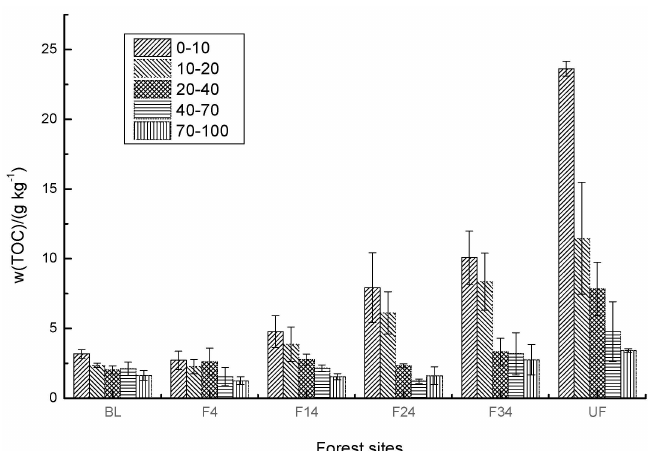
Figure 2. The depth distribution of SOC concentration in di ff erent forest sites. Values are mean ± SD, n = 3; BL: Bare land; F4, F14, F24, and F34: the forest sites of 4 years, 14 years, 24 years, and 34 years since the completion of combined measures; UF: nearly undisturbed old-growth forest